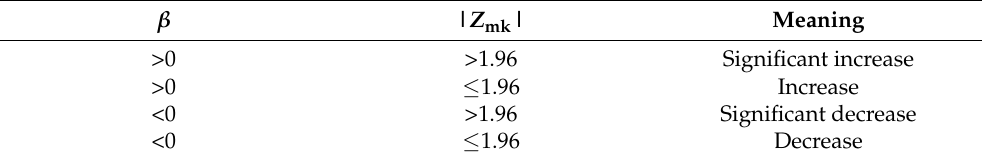
Table 2. Classification of Carbon Flux